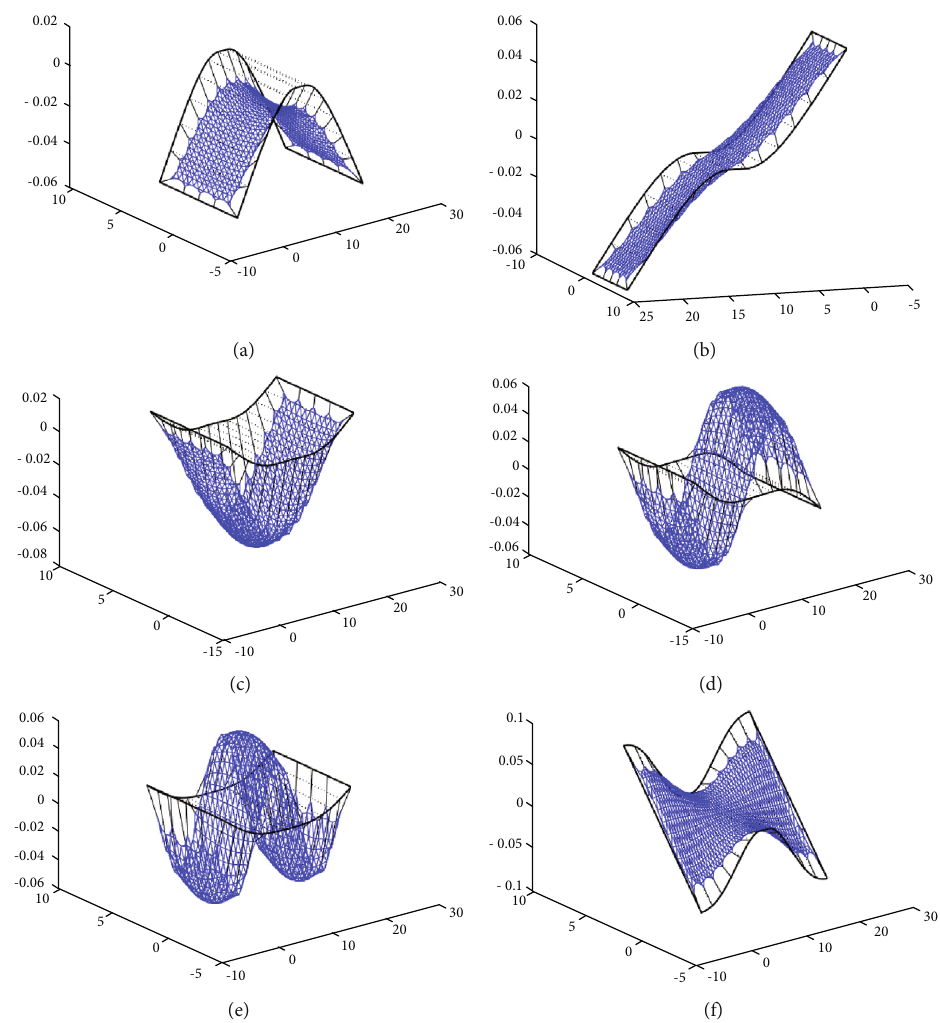
Figure 10: Vibration modes of the membrane antenna structure under the heat fl ux as 1831W/m2: (a) fi rst mode; (b) second mode; (c) third mode; (d) fourth mode; (e) fi fth mode; (f) sixth